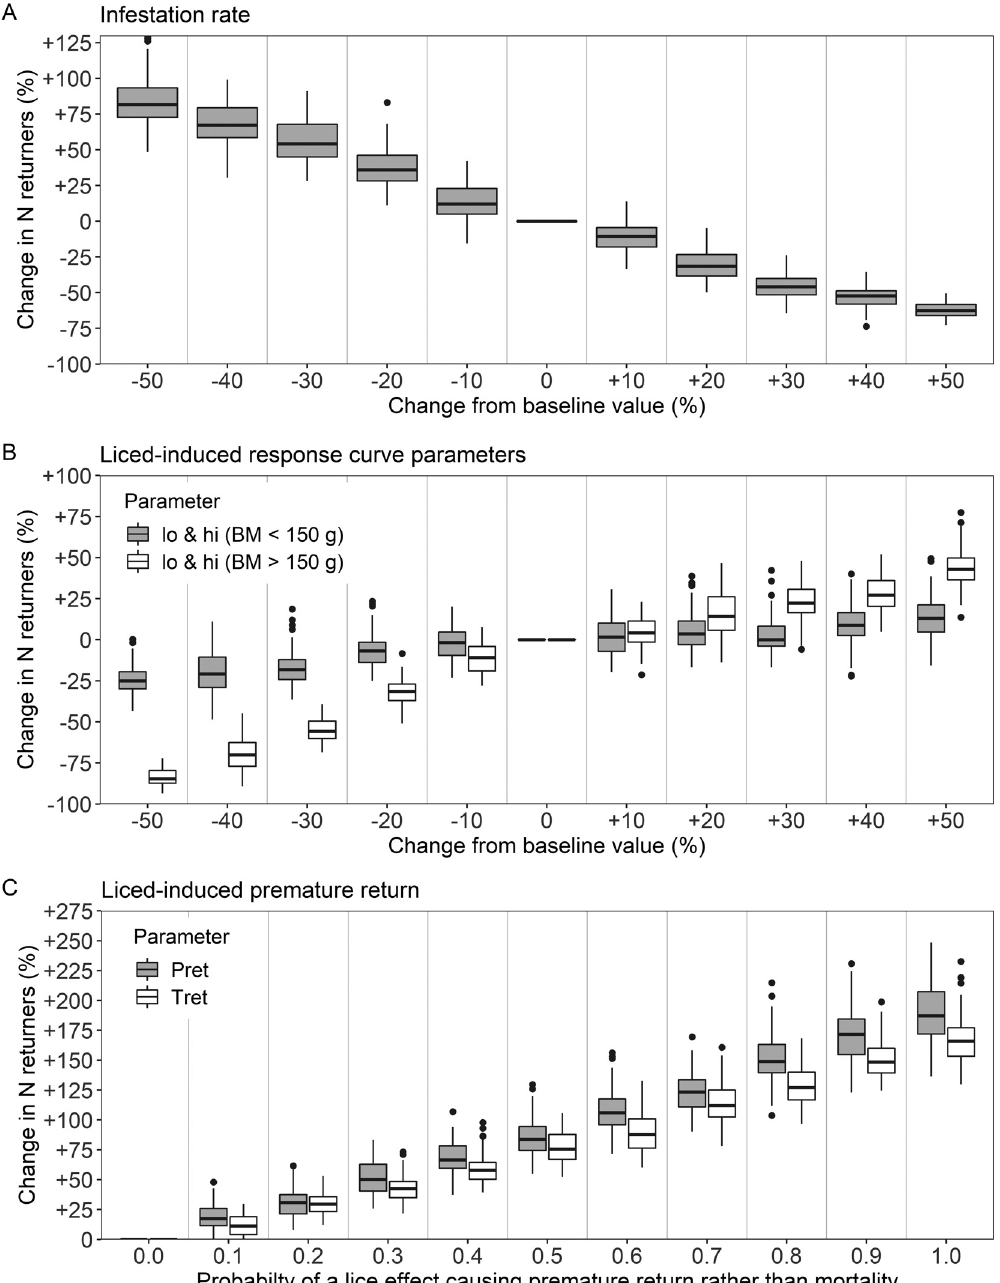
Fig. 8. Sensitivity of number of returners to (A) infestation rate, (B) parameters of lice-induced response curve and (C) type of response to lice infestation. In (B), lo and hi values have been changed separately for small (body mass < 150 g) and large (body mass ≥ 150 g) individuals. In (C), the change in number of returners is expressed relative to the simulation where there is zero probability of a lice effect causing premature return and a probability of 1 that such an effect will cause